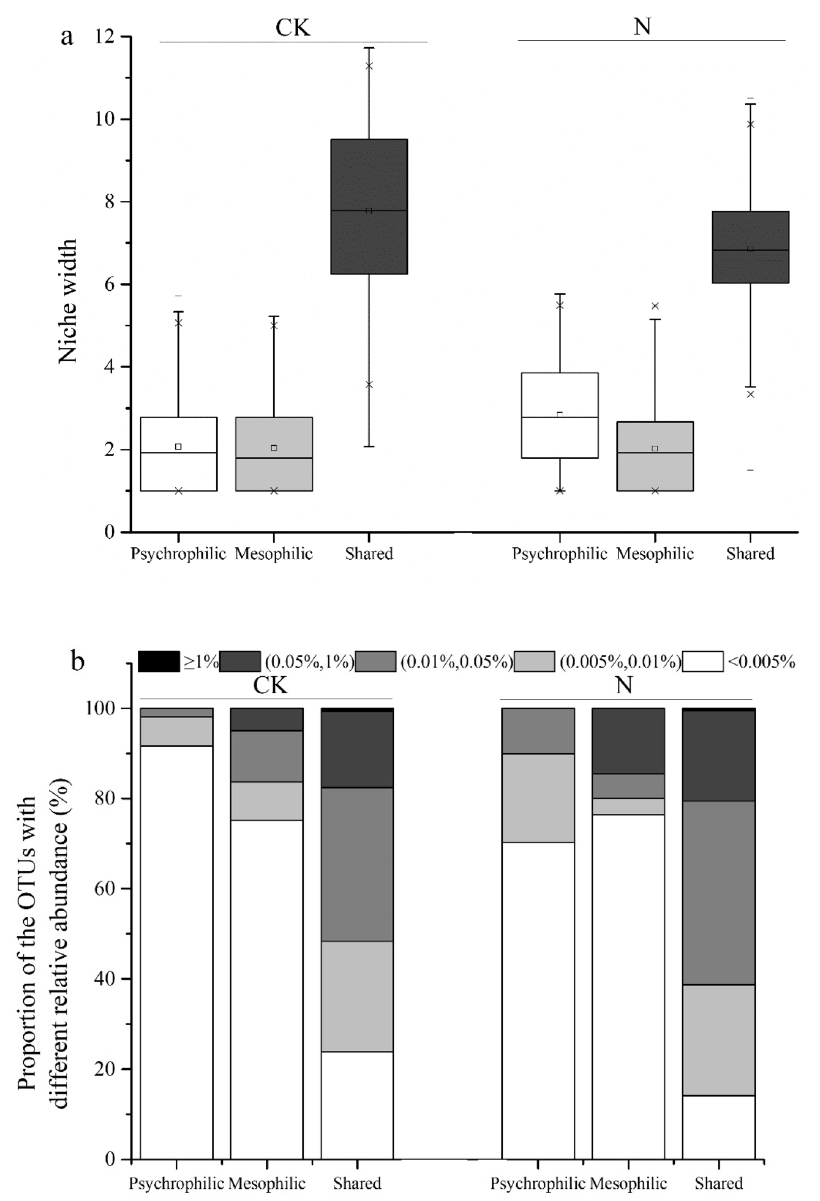
Figure 3. Niche width ( a ) and abundance frequency ( b ) of psychrophilic, mesophilic, and shared OTUs. CK, soil samples with no nitrogen application; N, soil samples with nitrogen application; psychrophilic OTUs, OTUs that are present at 5 °C and/or 15 °C treatments; mesophilic OTUs, OTUs that are present at 25 °C and/or 35 °C treatments; shared OTUs, OTUs detected in all treatments. In ( b ), ≥ 1% represents relative abundance higher than or equal to 1%, < 0.005% represents that lower than 0.005%, (0.05%,1%) represents relative abundance higher than or equal to 0.05% and lower than 1%, and so